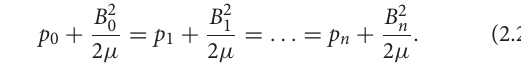
B j / √ µρ j and c j =